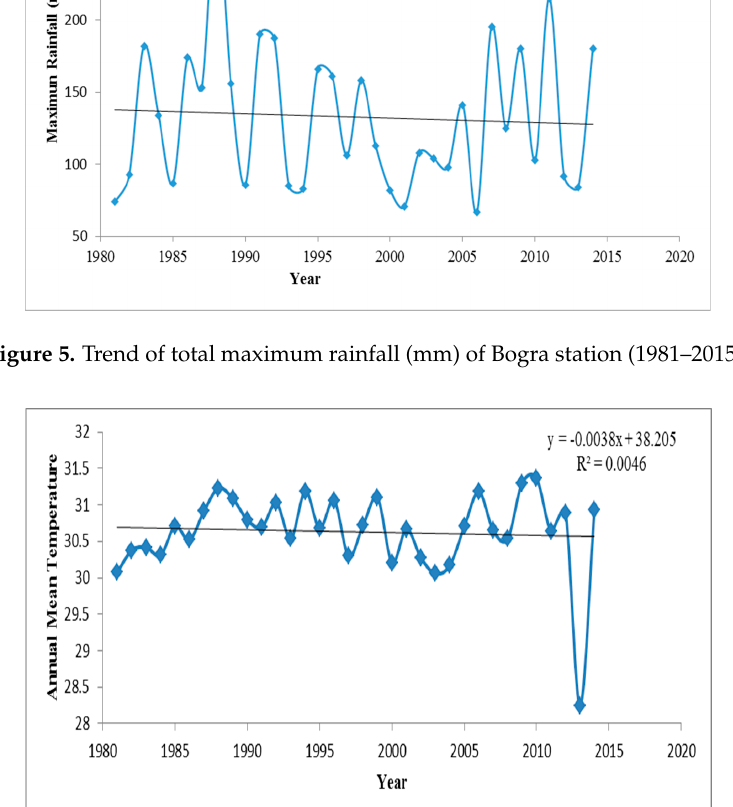
Figure 6. Trend of annual mean temperature (0 °C) of Bogra station (1981–2015).